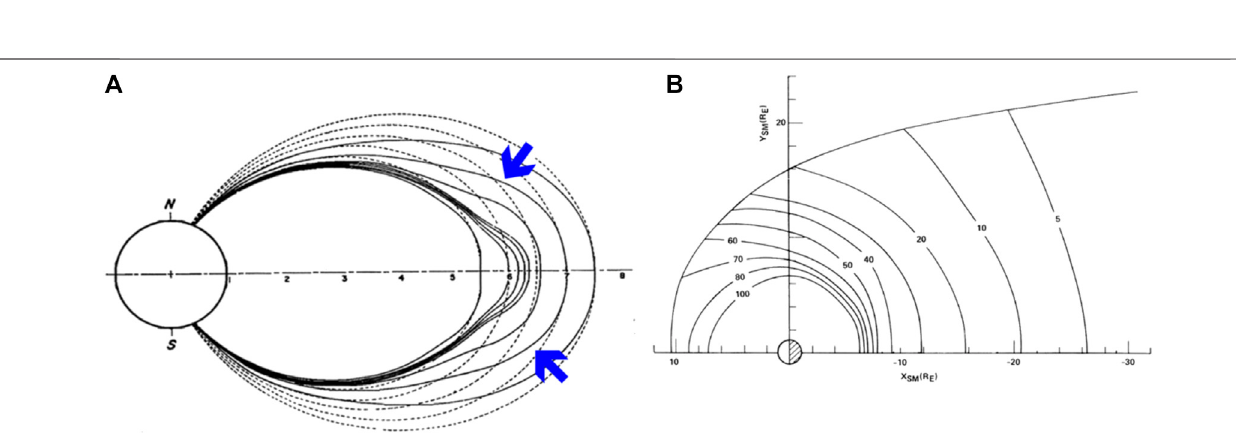
Frontiers in Astronomy and Space Sciences |